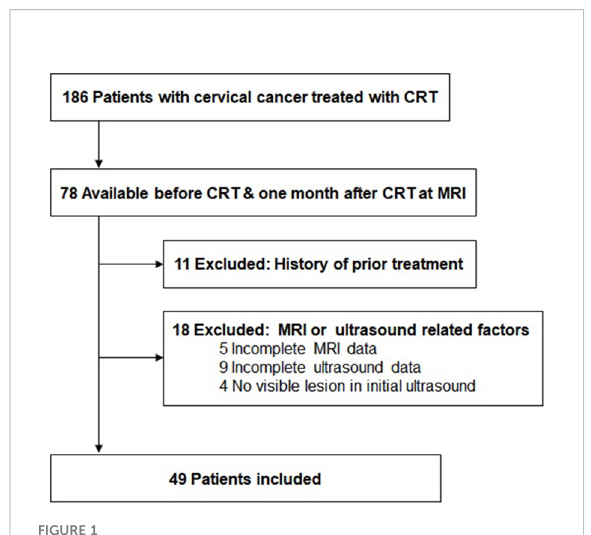
FIGURE 1 Flowchart of patient enrollment. CRT, chemoradiotherapy.